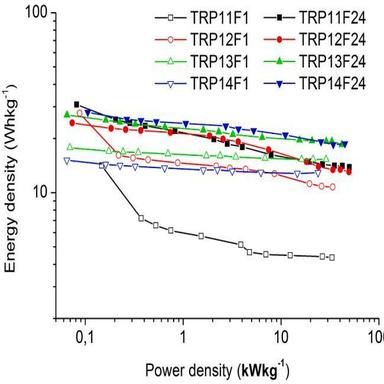
Bode plots of F-doped SiOC-DC samples.